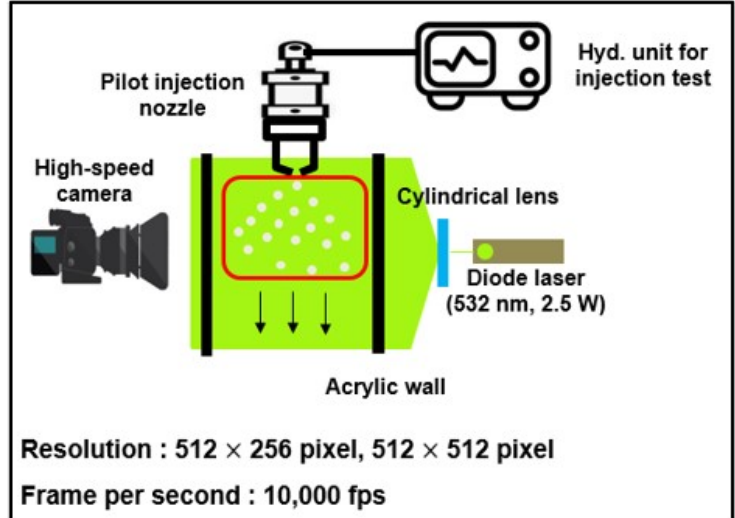
Figure 4. Schematic of experimental setup for simulation validation.